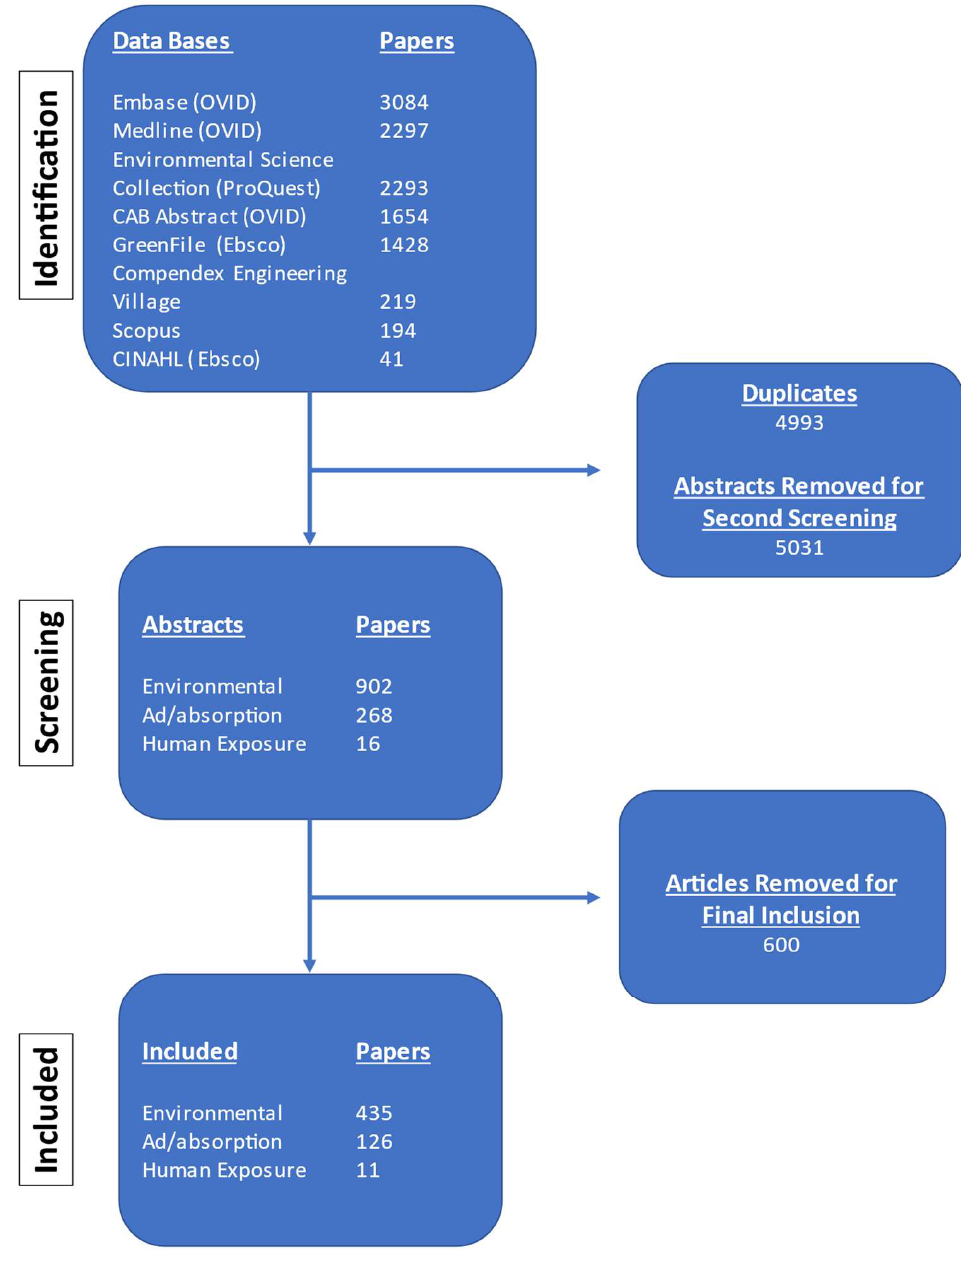
Figure 1. Search strategy